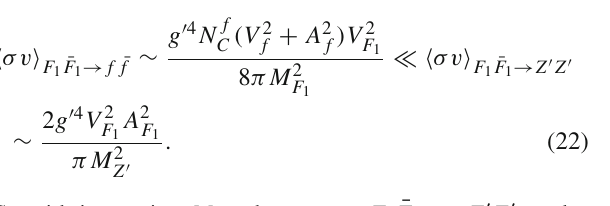
Fig. 6 Relic density as a function of scalar DM mass M , − 4 , 3 Q = − 1 . (c) Q = − 1 , g (cid:2) = 0 . 2, M Z (cid:2) = 2 , 4 , 6 TeV. The cyan band corresponds to Planck measured result (cid:20) h 2 = 0 . 1199 ± 0 . 0027 4 2 4